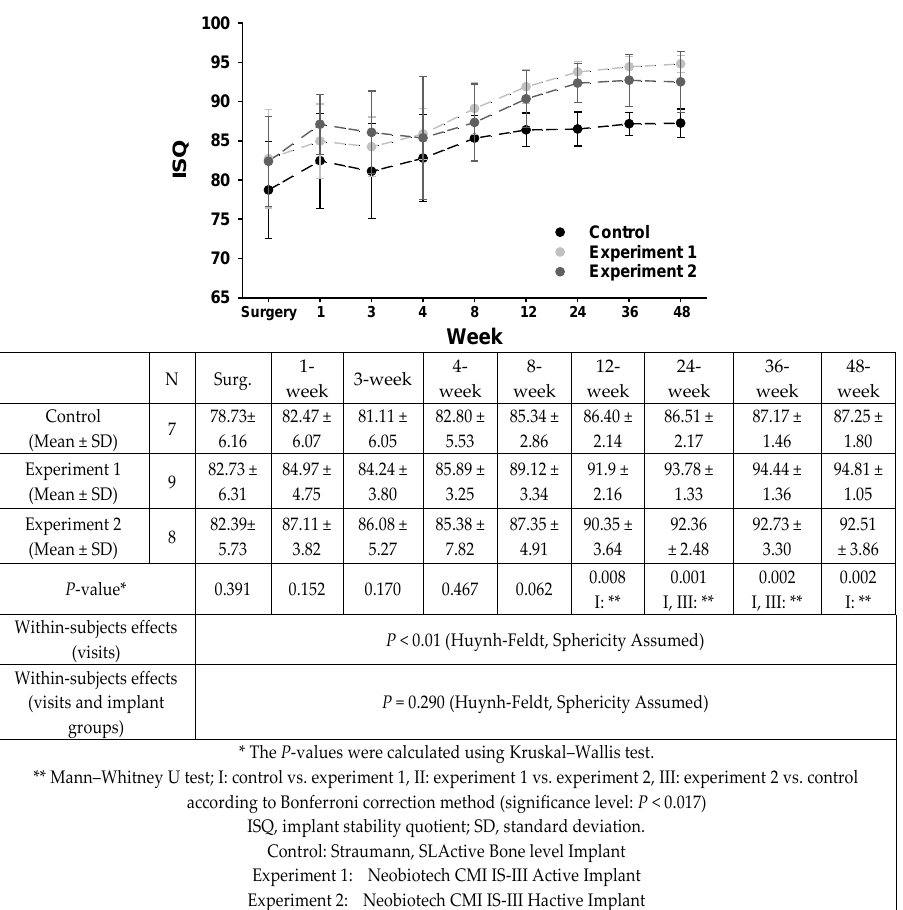
P = 0.290 (Huynh-Feldt, Sphericity Assumed)